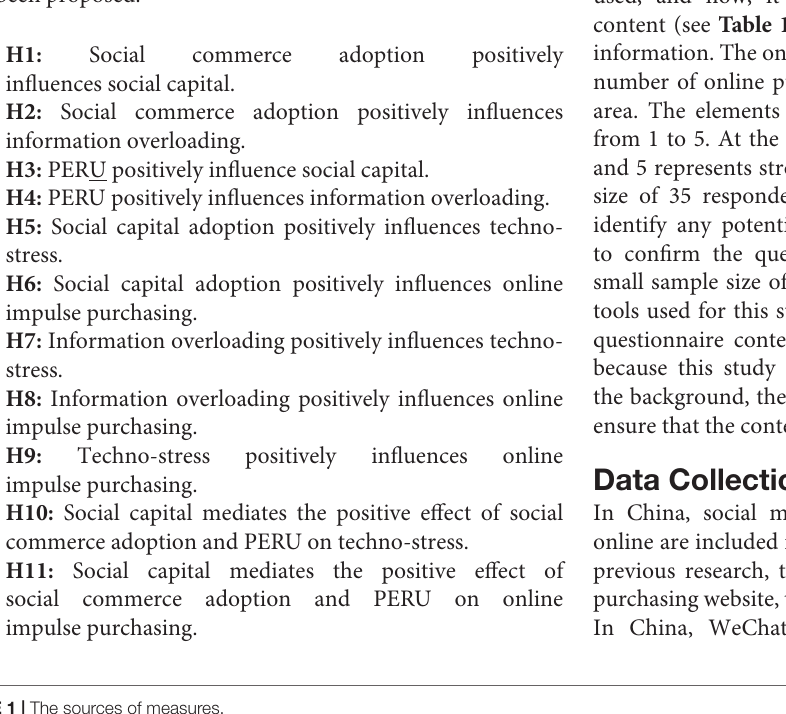
TABLE 1 | The sources of